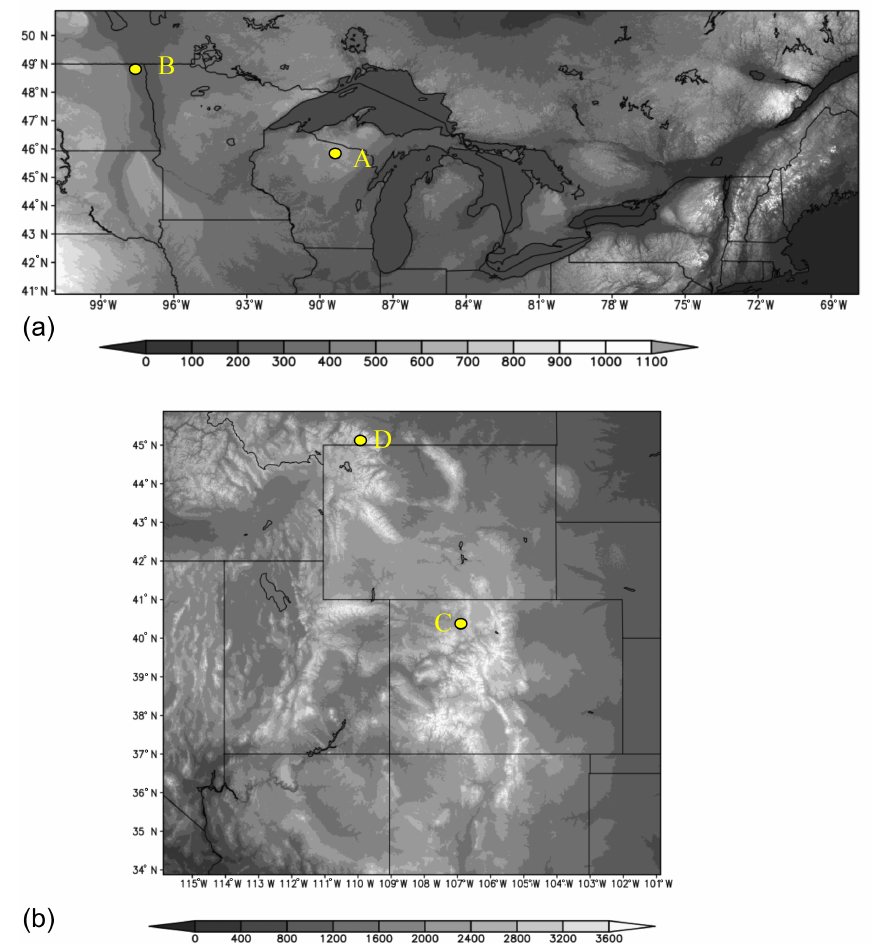
Figure 4. Two study domains with the 1km terrain elevation (m) as the background: (a) GL domain and (b) CH domain. The yellow circles indicate the locations of the grid cells used for time series